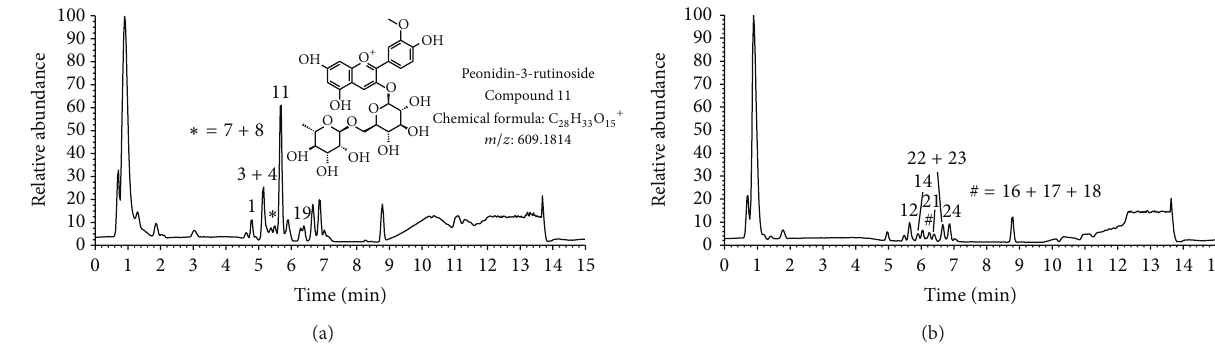
Figure 2: Base peak chromatograms of (a) cherry wine and (b) Cabernet Sauvignon-Central Serbia in positive ion mode.